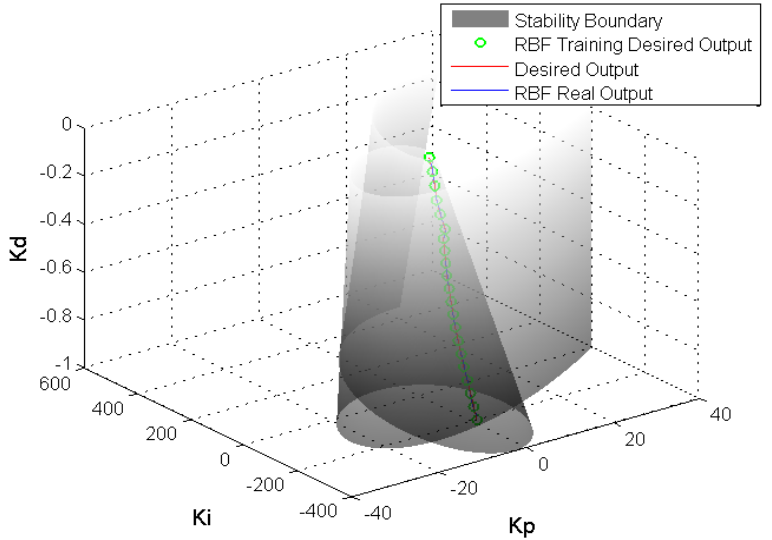
Figure 16. The 3D stability boundary in parameter